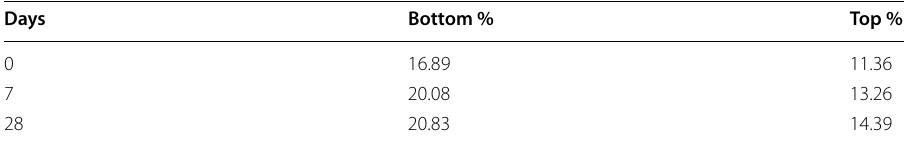
Table 5 Variation of CBR value of improved sludge with 30% flyash according to curing